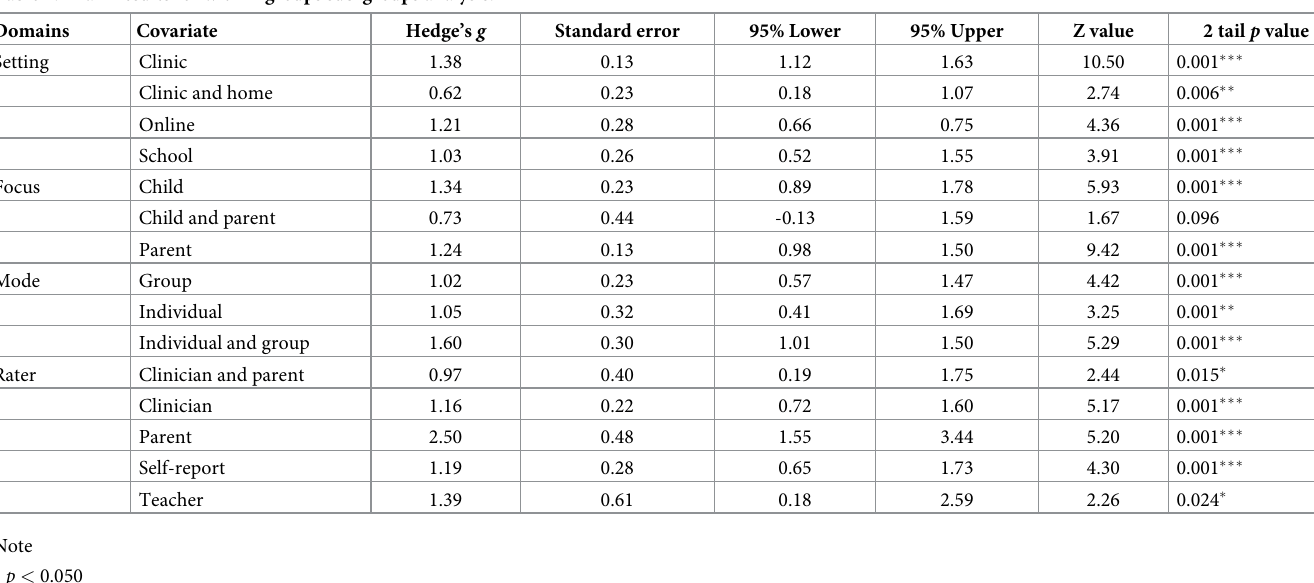
Table 4. Main results for within-groups sub-groups